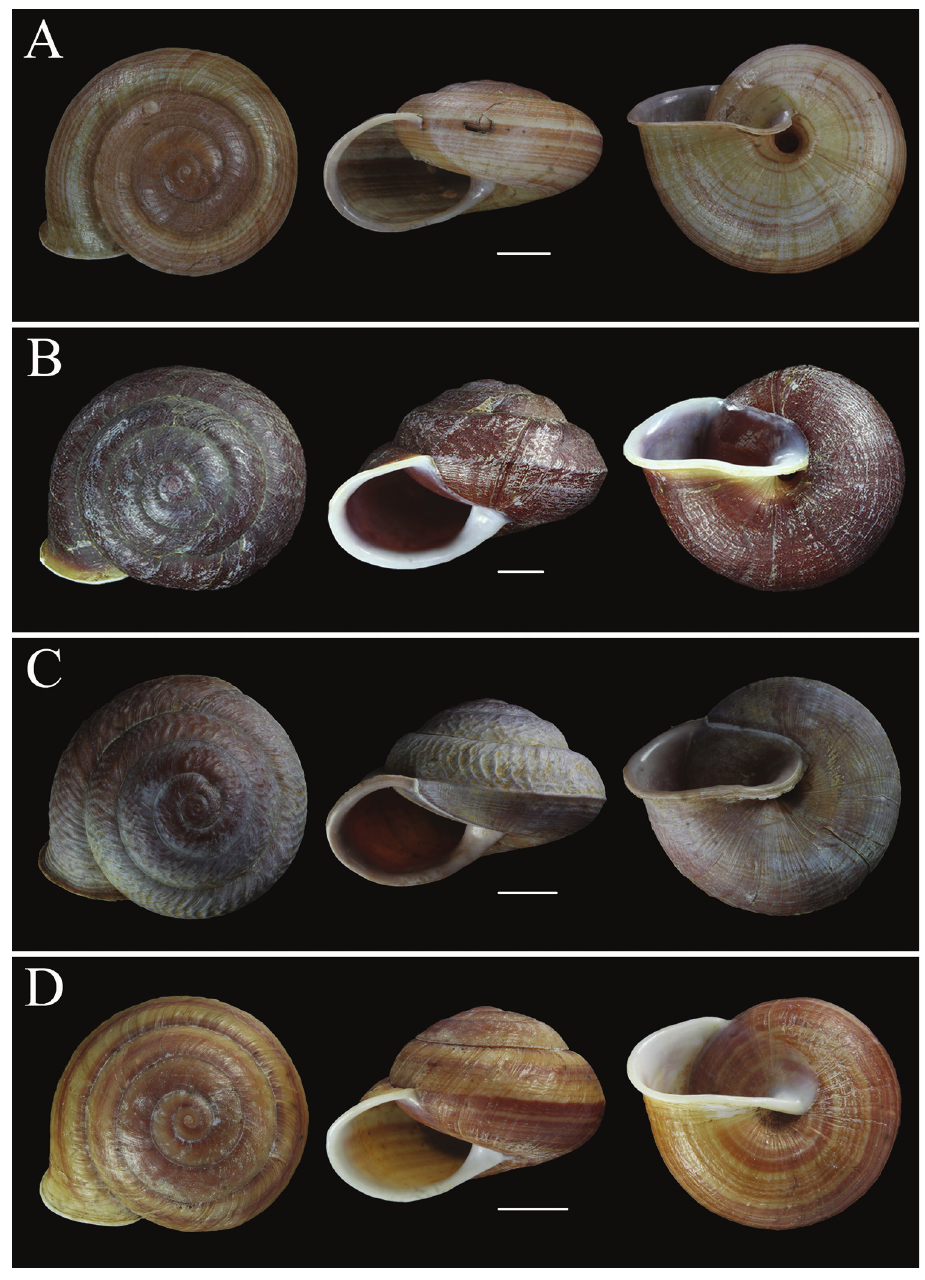
Figure 3. Photographs of shells. A Camaena lingyunensis sp. n. (holotype, FJIQBC 19280, Kasuo, Ling- yun, Guangxi, China) B Camaena detianensis sp. n. (holotype, FJIQBC 18472, Detian Falls, Daxin, Guangxi, China) C Camaena hahni (FJIQBC 19300, Huu Lien Nature Reserve, Lang-Son, Vietnam) D Camaena cicatricosa (FJIQBC 18505, Guiping, Guangxi, China). Scale bars 10